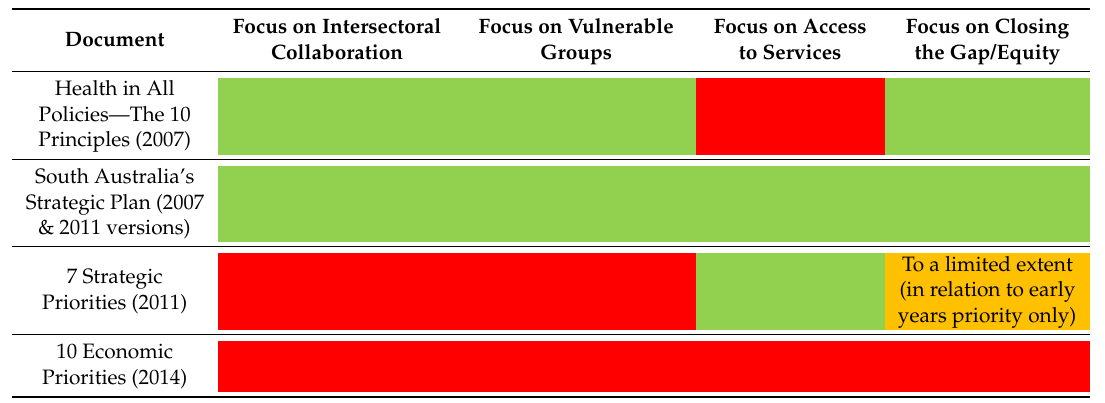
Table 2. Equity focus of key strategic priority and direction setting